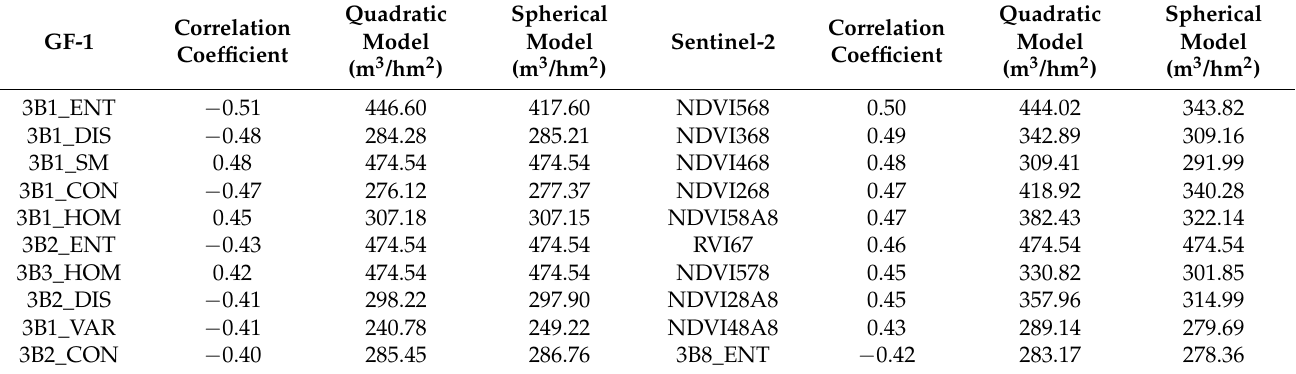
Table 3. Spectral saturation levels of the top ten feature variables using two models for different images.